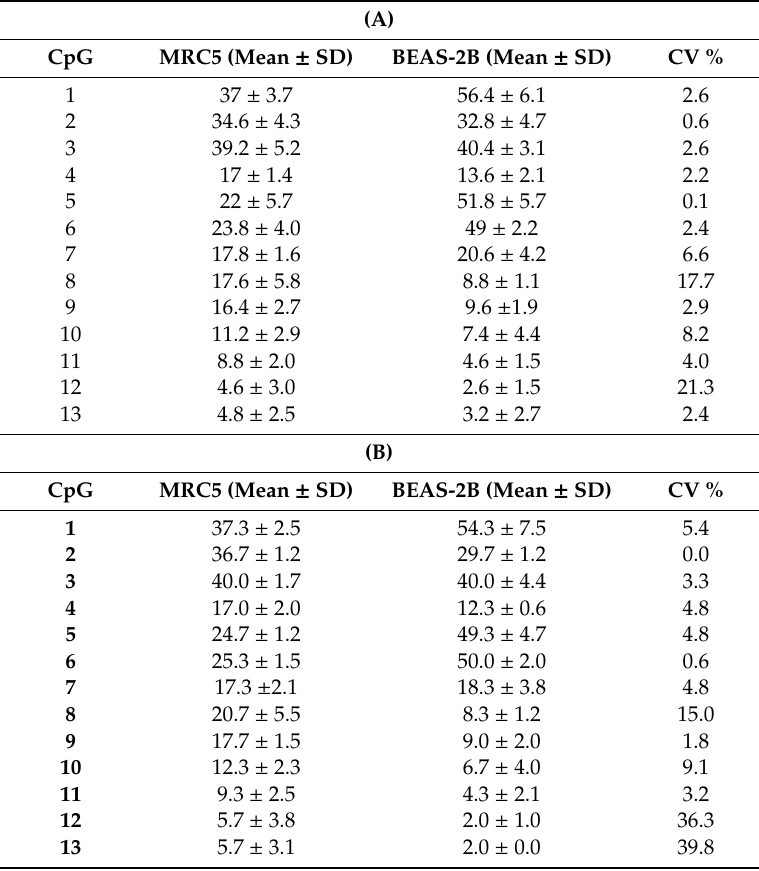
Table 3. ( A ) Inter-assay precision for KEAP1 P1 promoter methylation analysis by pyrosequencing (single CpG). ( B ) Intra-assay precision for KEAP1 P1 promoter methylation analysis by pyrosequencing (single CpG).